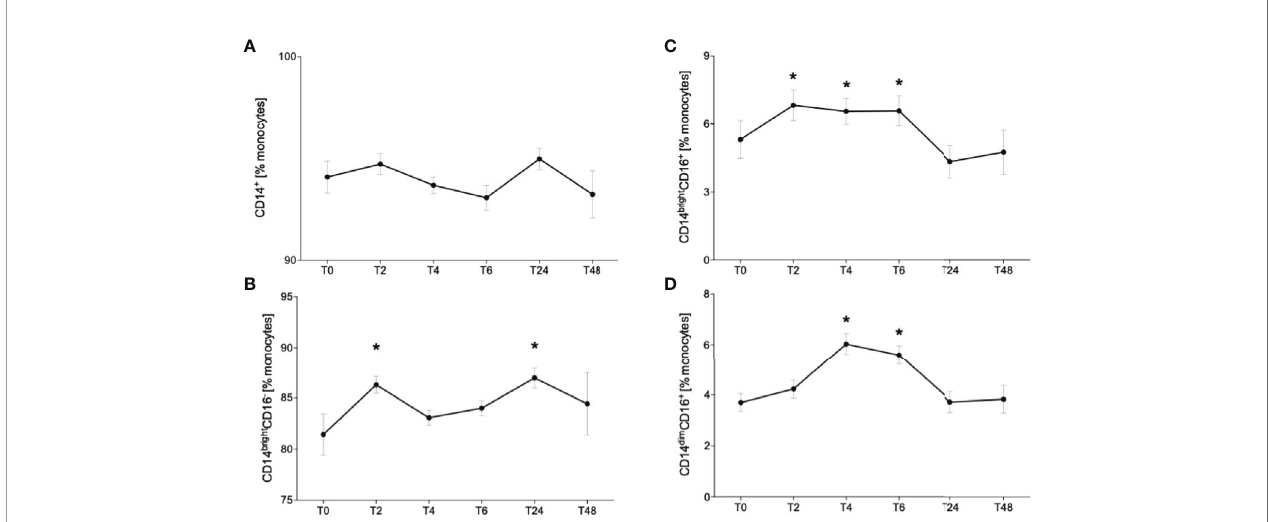
FIGURE 3 | Impact of acute alcohol intoxication on monocyte subset distribution. Percentage distribution of CD14 + (A) classical (CD14 bright CD16 - ) (B) , intermediate (CD14 bright CD16 + ) (C) and non-classical (CD14 dim CD16 + ) (D) was determined in blood of healthy volunteers (n=22) before (T0) and 2 (T2), 4 (T4), 6 (T6), 24 (T24) and 48 (T48) hours after starting the alcohol consumption. Data are presented as mean ± standard error of the mean. *p < 0.05 vs .